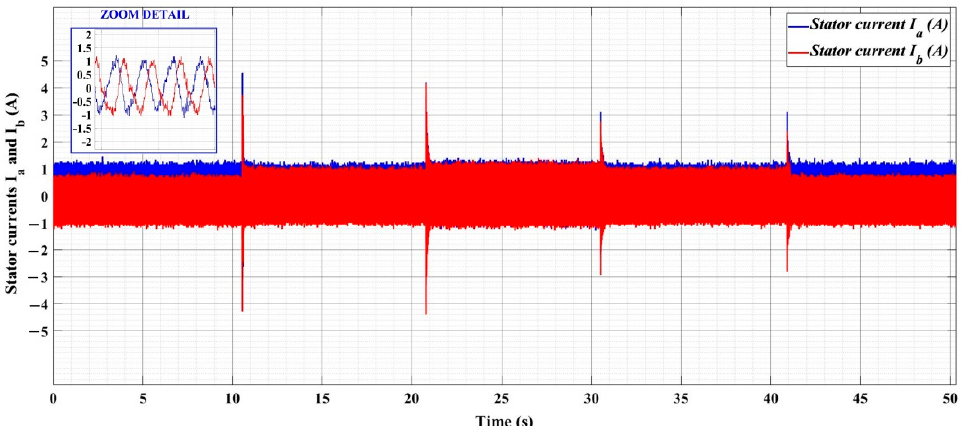
Figure 38. Real-time evolution for i a and i b stator currents—HIL stage; T L = 1 Nm.